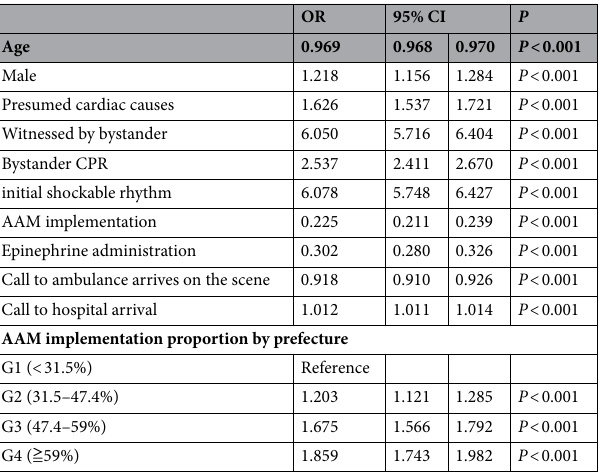
Table 2. Multivariate analysis for Survival with CPC1 or 2. CPC the cerebral performance category, OR odds ratio, CI confidence interval, CPR cardiopulmonary resuscitation, AAM advanced airway management.